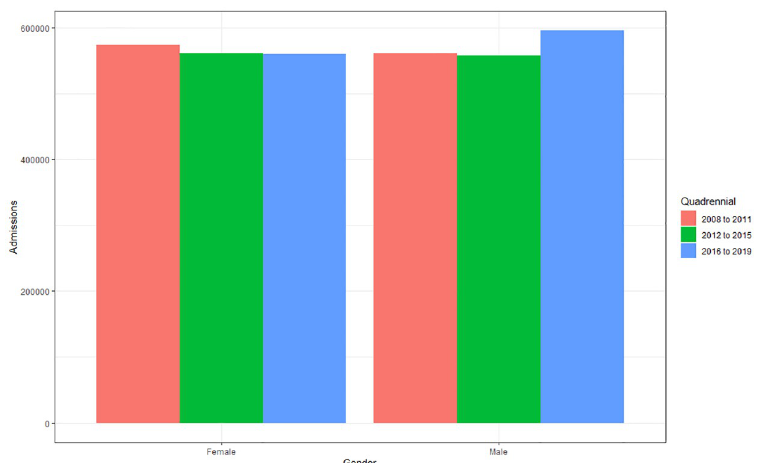
Fig 4. Average of hospital admissions caused by cardiovascular diseases according to gender and quadrennium (2008 to 2011; 2012 to 2015; 2016 to 2019). Source: Ministry of Health–Hospital Information System of the Unified Health System (SIH/SUS)